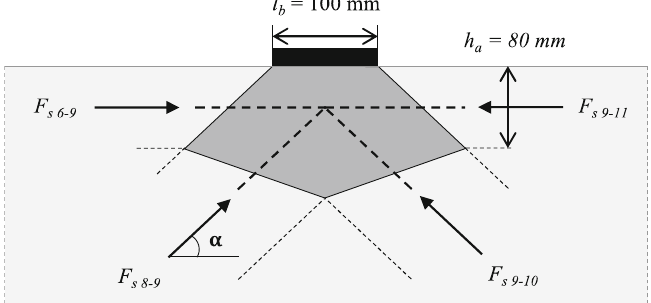
Fig. 8 Nodal zone 9 in type B specimen.